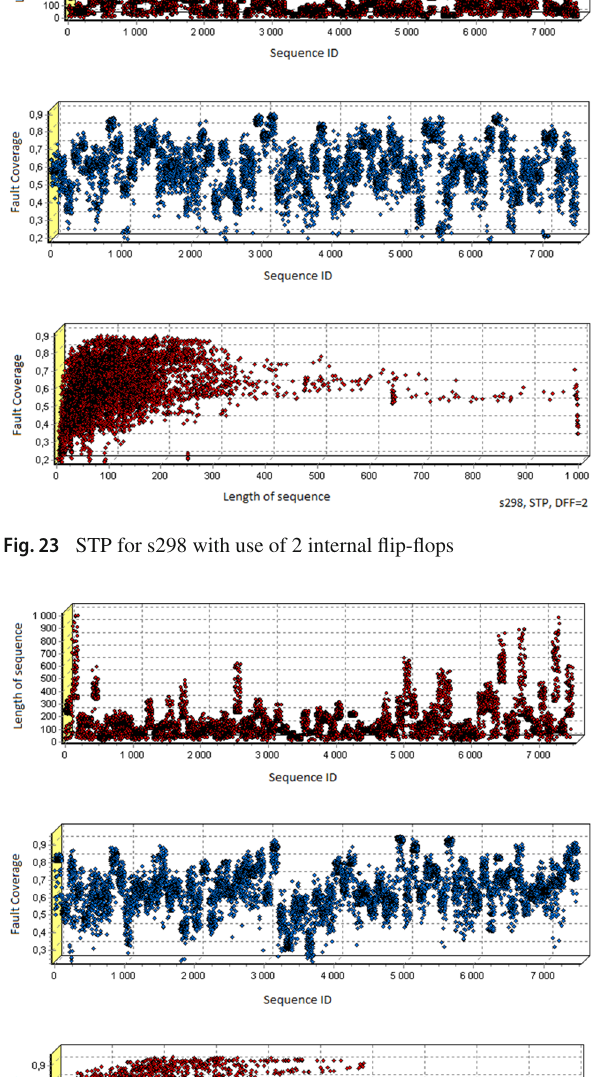
the variety of ATS structures researched. Figures 21, 22, 23, 24, 25, 26, 27, 28, 29, 30, 31, 32, 33, 34 and 35 show in detail the effect of incremental including internal memory elements of a sequential circuit into STP structure on diag- nostic performance of s298 circuit testing. With the